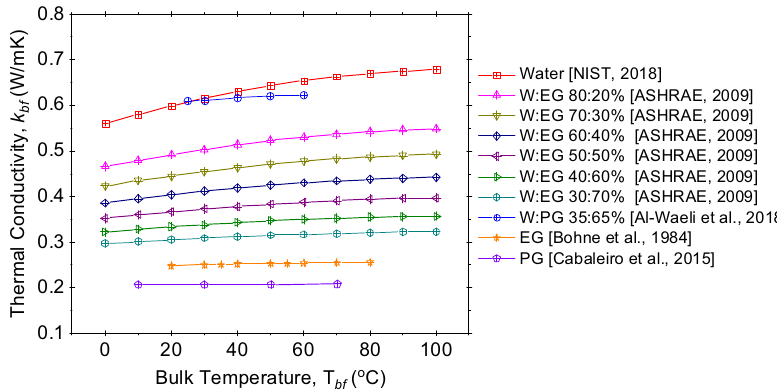
Figure 2: Thermal conductivity of conventional base fl